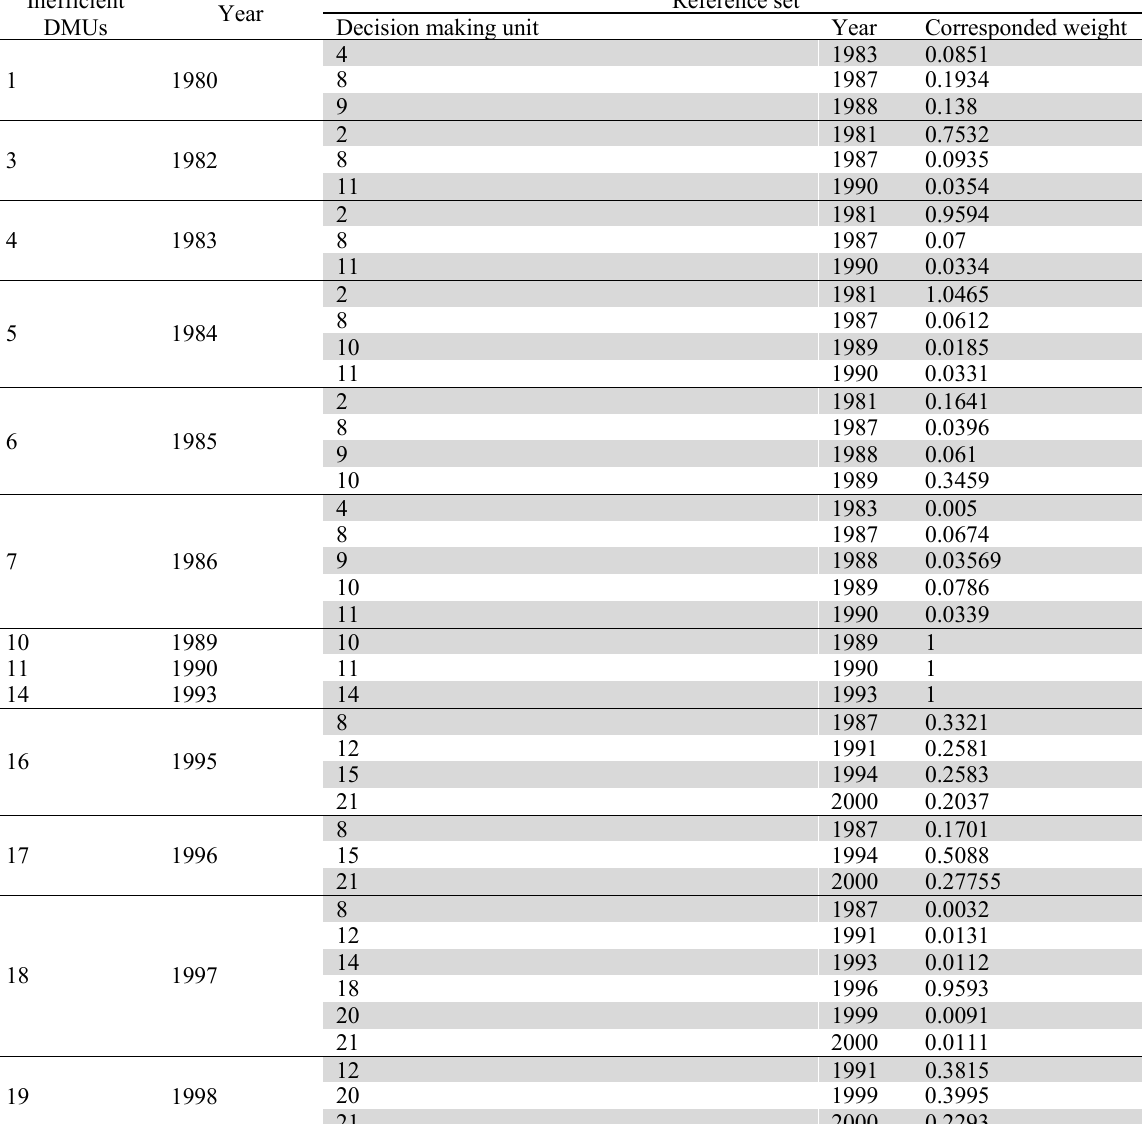
Reference sets for inefficient units and their corresponded